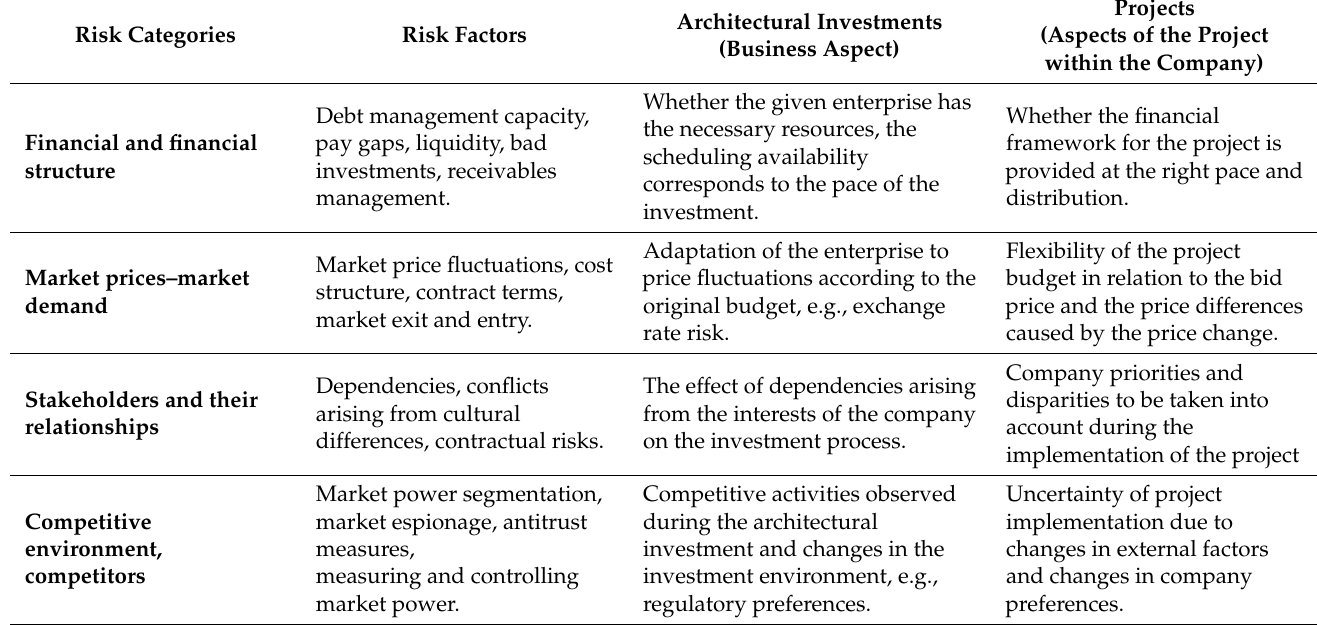
Table 1. Grouping of identified risk factors. Source: Boehlje and Lins 1998, supplemented by secondary sources and with empirical